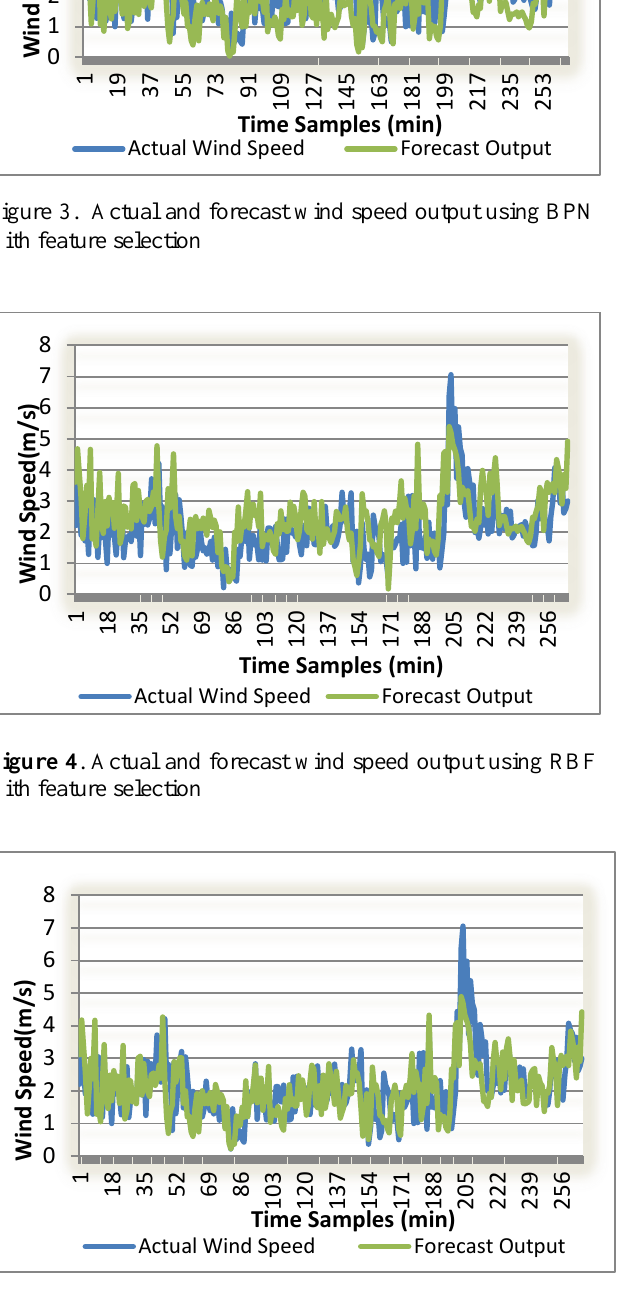
Figure 5 . Actual and forecast wind speed output using NARX with feature